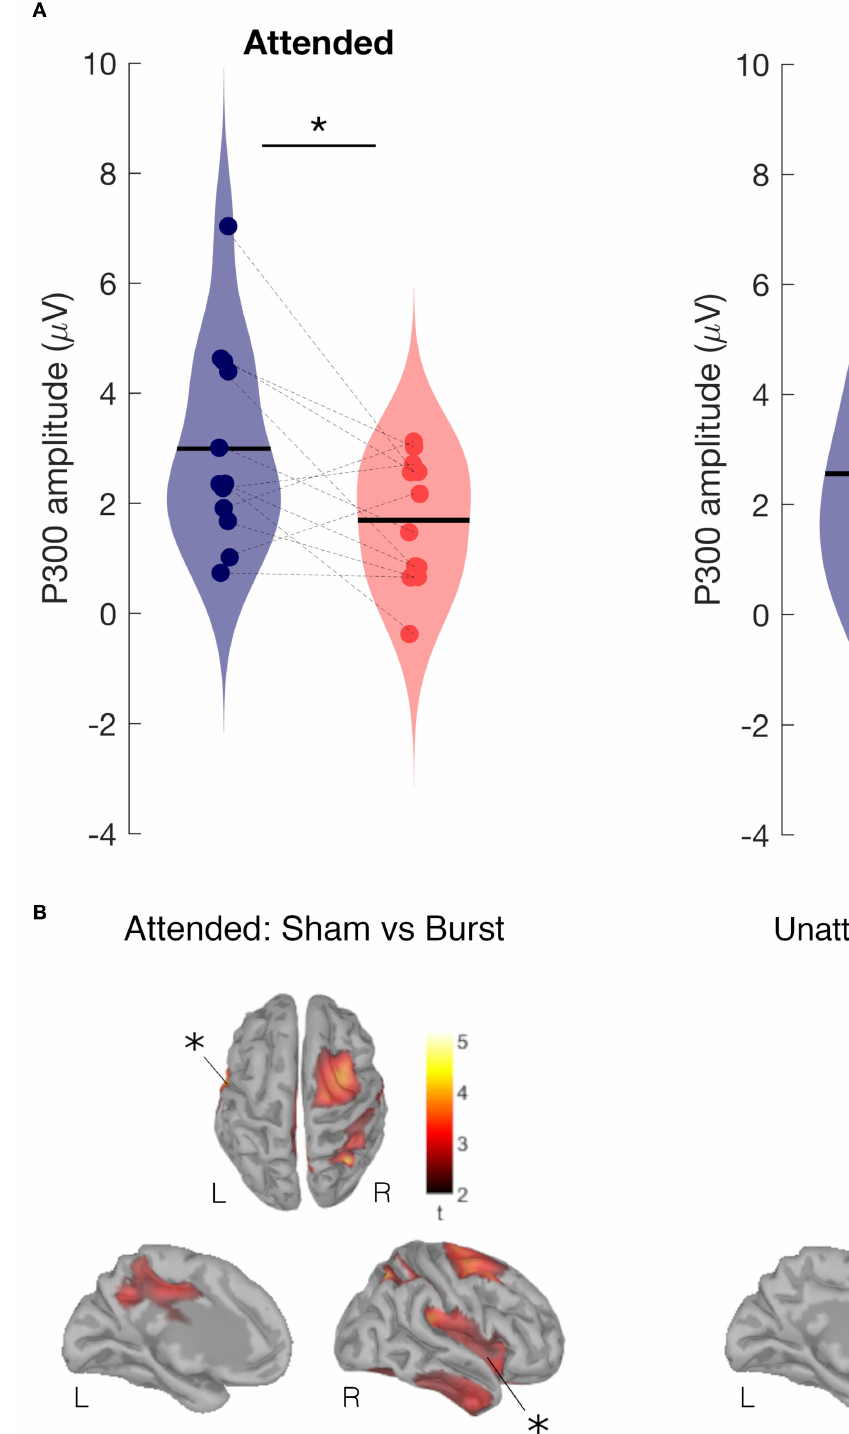
FIGURE 4 | Attended and unattended condition. (A) P300 amplitude of SEP at the vertex during burst SCS (red) and during sham SCS (blue). Two-sided Wilcoxon signed rank test, * p < 0.03. (B) Effect of burst vs. sham SCS on brain sources averaged for the P300 period (250 to 300ms), cluster based permutation test on the absolute values (paired t -test, 1,000 permutations, cluster alpha 0.05). Top view (top), left hemisphere internal view (left), and right hemisphere (right). Results show Sham > Burst in right supplementary motor area, somatosensory cortex, mid cingulate cortex, and left and right insular cortices. Statistically significant results are indicated with